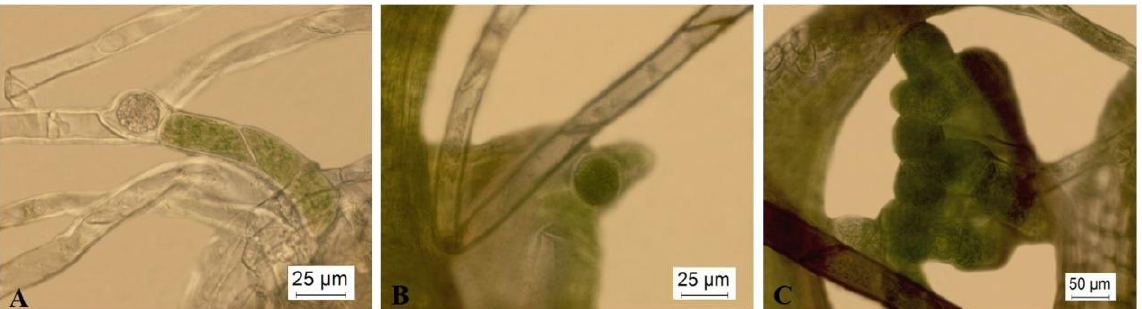
Figure 7. The formation of brachycytes in Pterygoneurum sibiricum explants grown on KNOP nutrient medium supplemented with different NaCl concentrations: ( A ) 50 mM NaCl; ( B ) 100 mM NaCl; ( C ) 250 mM NaCl.